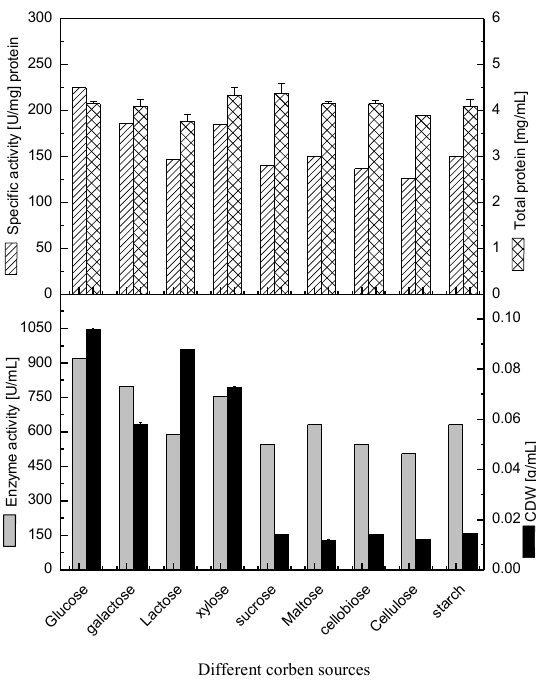
Figure 4 Effect of different carbon source on the production of alkaline protease produced by Str. pseudogrisiolus NRC-15 on 200 rpm at 96